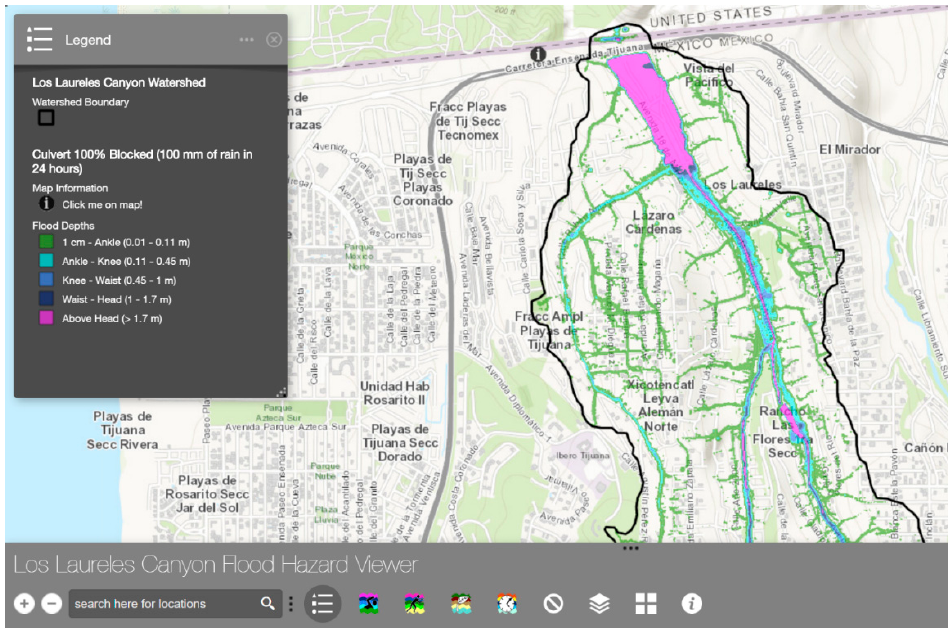
Figure 3. Map of maximum flood depth from a 100 mm rainfall scenario under a complete culvert blockage scenario, resulting in extensive ponding (above head, > 1.7 m) near the outlet (northern boundary) of the catchment. Resident interviews generated a report that a mattress previously clogged the main culvert, leading to deep flooding.